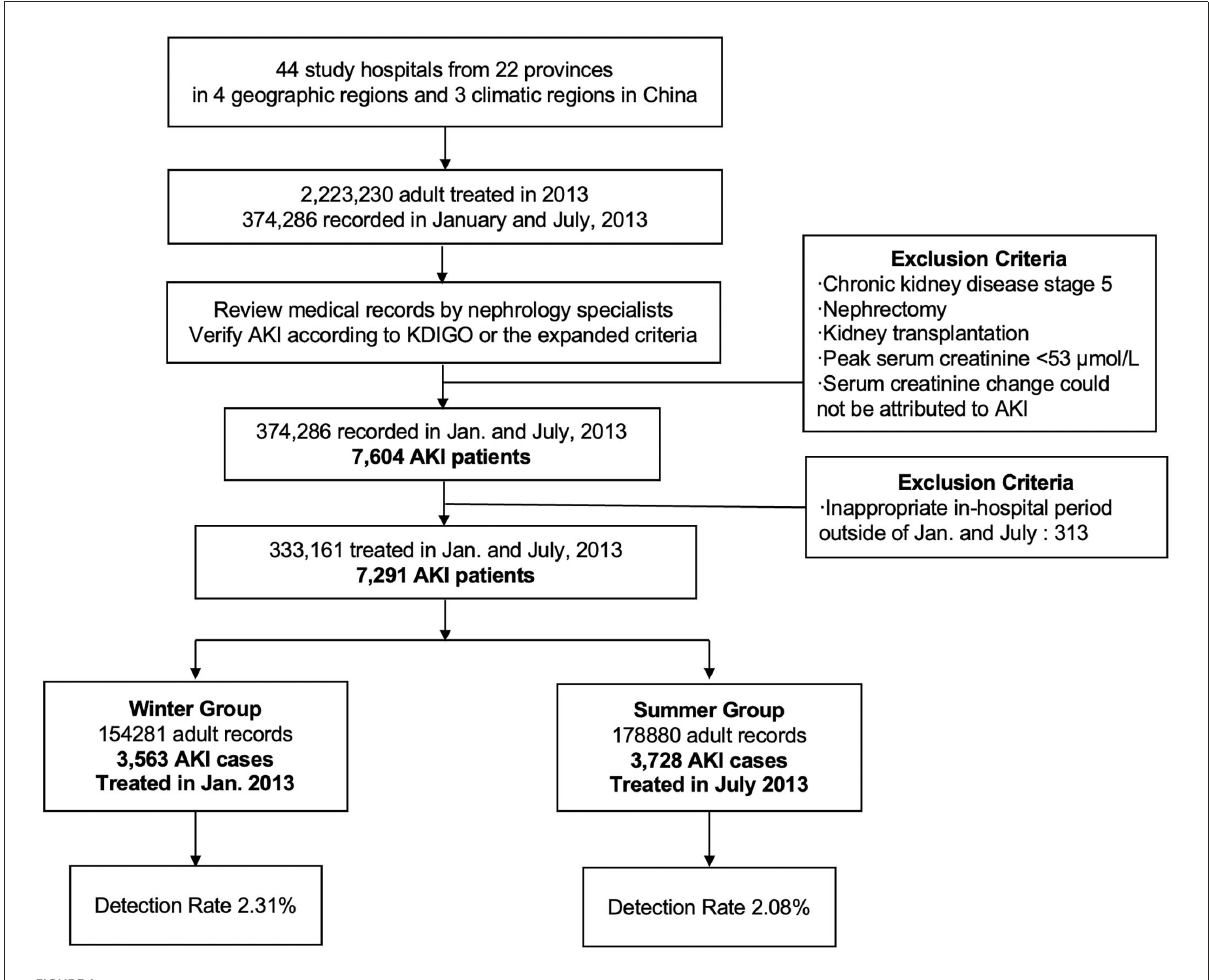
FIGURE1 The flowchart of study